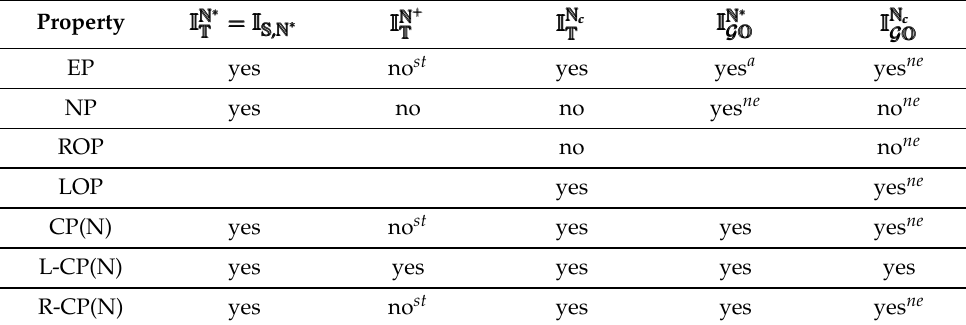
Table 2. Some properties of fuzzy implication